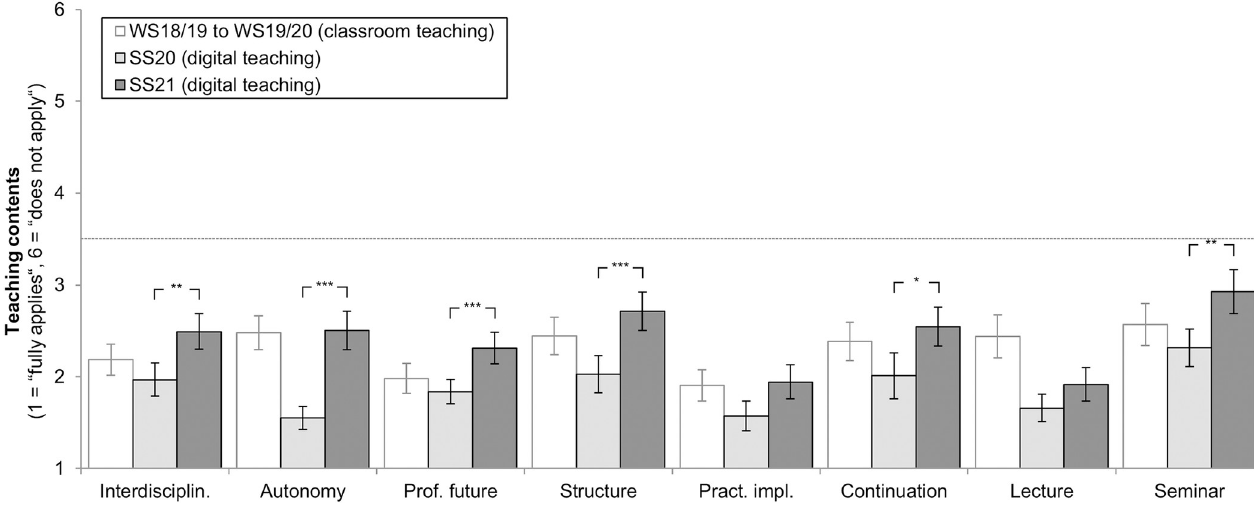
Fig 2. Teaching contents rated by students for SS20 ( n = 175) and SS21 ( n = 136). � p < 0.05, �� p < 0.01, ��� p < 0.001. Mean values with 95%-CIs and Bonferroni corrected pairwise comparisons. Students rated statements on a 6-stage scale (1 = “fully applies”, 6 = “does not apply”), e.g., “This module should be continued as is with respect to the subject of psychiatry” (please see S1 Table for all item formulations): (1) implementation of interdisciplinary teaching, (2) promotion of independent learning (autonomy), (3) knowledge gain related to professional future, (4) satisfaction with the basic structure of the module, (5) practical implementation of teaching, (6) preference to continue the module in this form, (7) subjective learning progress through lectures, (8) subjective learning progress through seminars. Ratings from semesters WS2018/19 to WS2019/20 (classroom teaching) were added as reference values for visual comparison. N = 311 (digital teaching), n = 175 (classroom